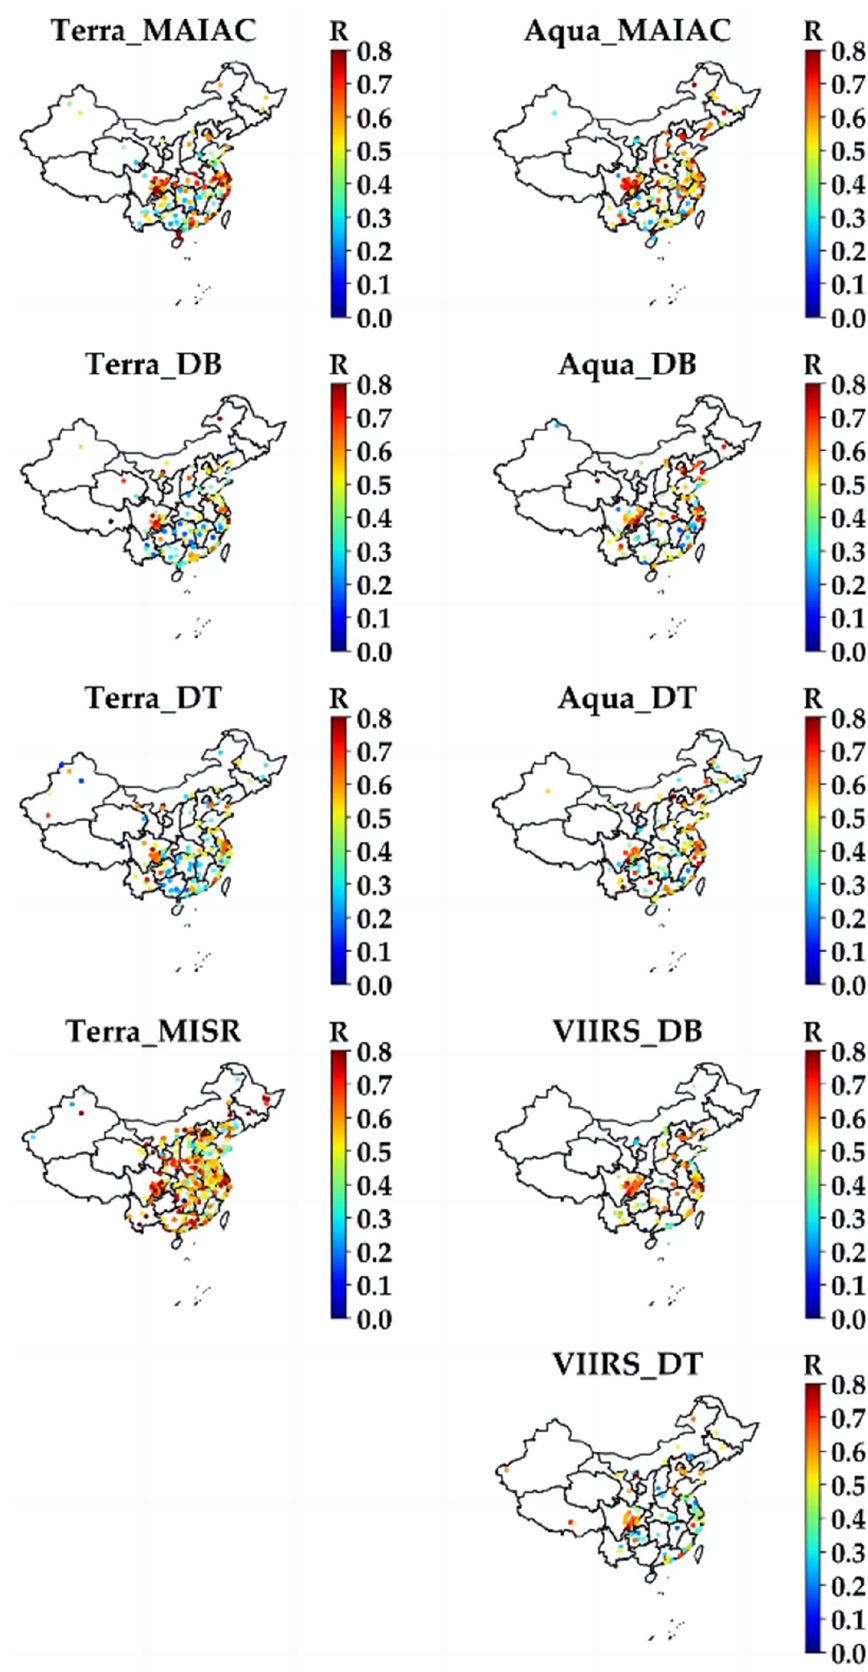
Figure 2. The spatial distribution of the correlation coefficient (R) between satellite AODs and